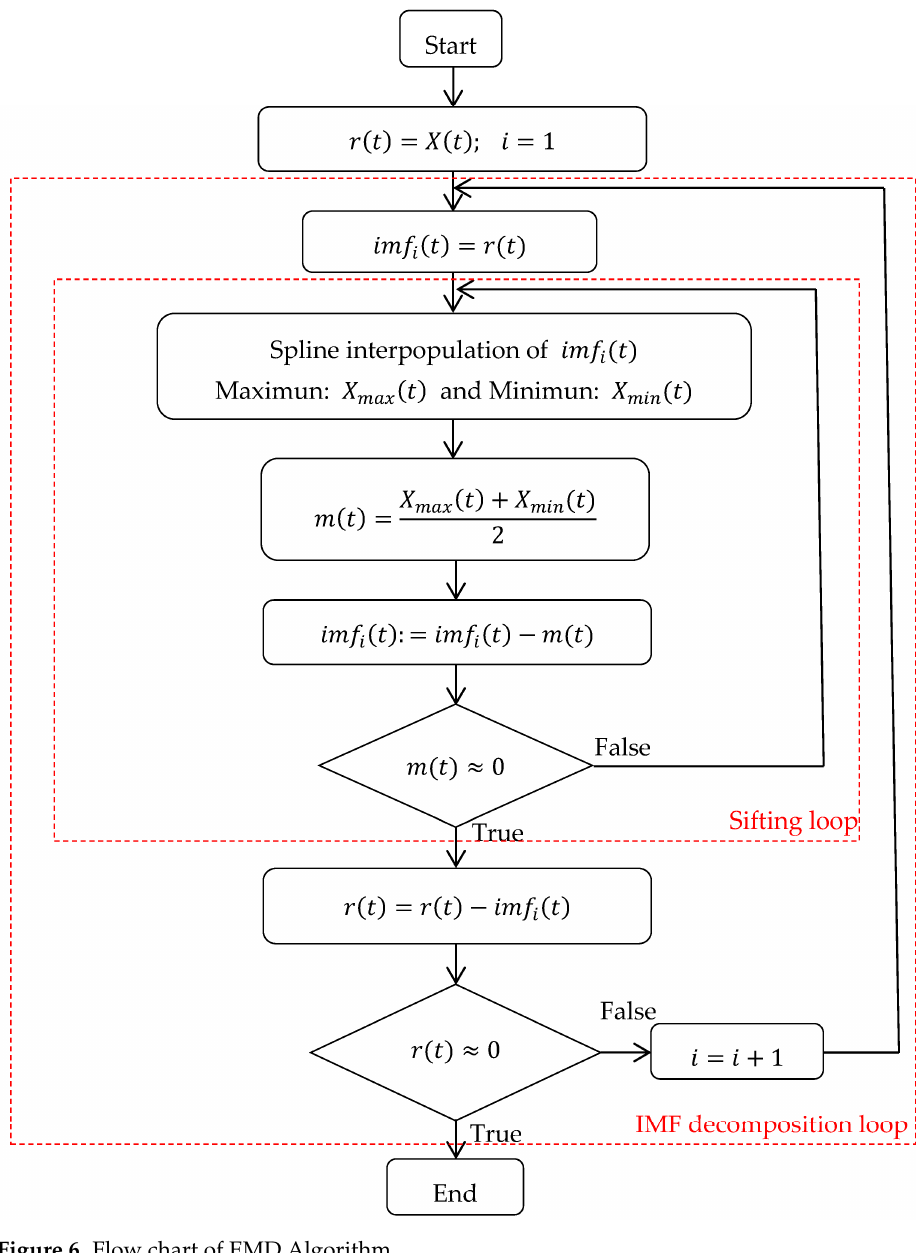
Figure 6. Flow chart of EMD Algorithm.